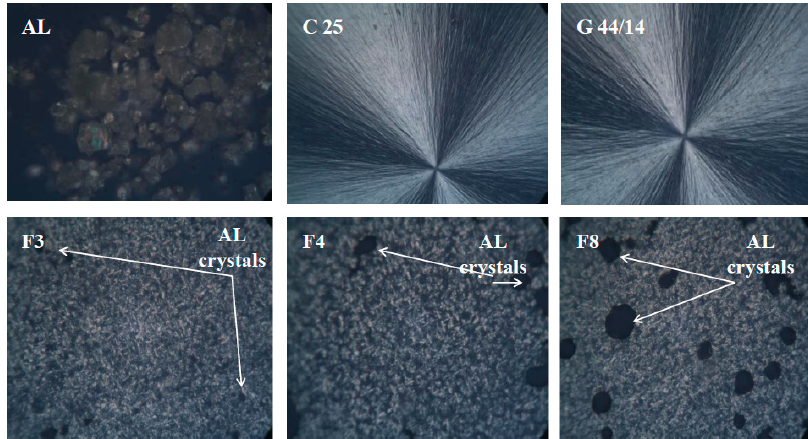
Figure 6. OMP images recorded on pure AL, C 25, G 44/14 and formulations F3, F4, F8.